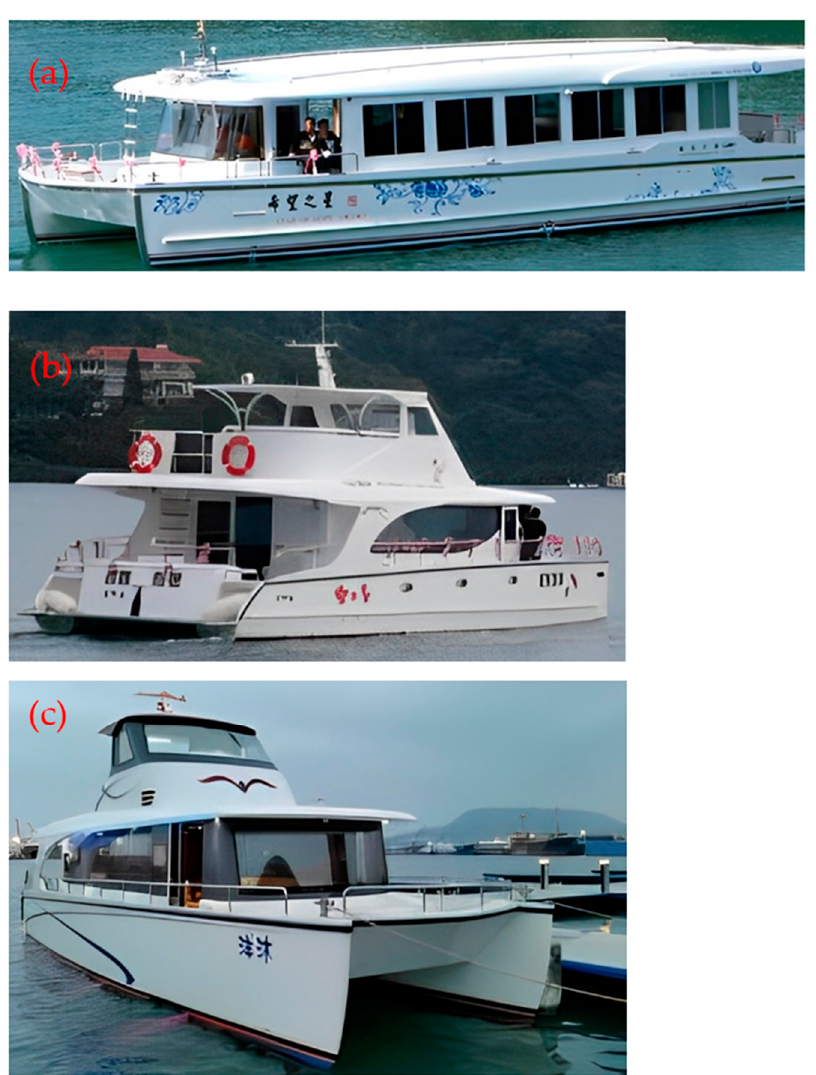
Figure 44. ( a ) The passenger ship “Star of Hope” [201,202]; ( b ) the passenger ship “Naruwa” [201,202]; ( c ) the passenger ship “Mu Yang” [201,202].